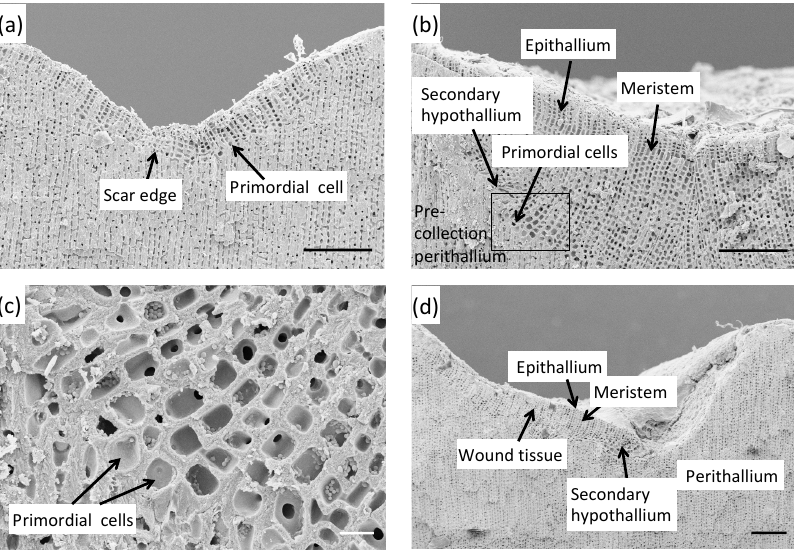
Figure 9. Example of wound recovery of C. compactum . (a) Section of C. compactum mound through the scar groove, collected from low- light, 2 ◦ C tank on 1 December 2012 after 2.5 months of recovery. Wound regrowth was initiated with one or more large primordial cells that gradually transition into normal perithallial cells. Following the production of three to four typical perithallial cells, meristem cells have developed and are beginning to produce epithallial cells (ClEx 121 211). (b) Scar groove section of C. compactum mound from the high- light, 2 ◦ C tank after 6 months of recovery. Groove has nearly grown in with normal meristem cells and perithallial and epithallial tissue. See blow-up of large primordial cells in (c) . (c) Primordial cells in lower left of section of (b) . These large ovoid to box-shaped cells typically have massive cell walls that appear to be a combination of inner cell wall and interfilament, crystals (ClEx 41 2hl). (d) Partially regrown scar ( ∼ 400µm at the deepest part) in C. compactum retrieved from 10 ◦ C high-light tank on 1 November 2012. Left side and shallower back portion of scar have formed new perithallium directly from old, pre-scar tissue. However, deeper bottom of scar is being filled by new hypothallium being topped with new perithallium. Allowing for late August and September recovery without growth, new wound tissue represents 1–2 months’ growth. Scale bars: 100µm (a, b, d) and 10µm (c)